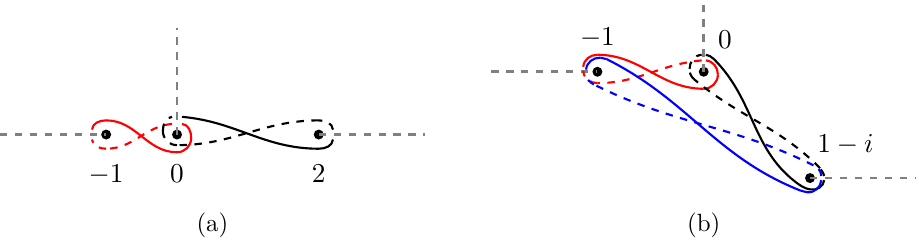
Figure 2. One-cycles on the WKB curves for the minimal chamber (a) and outside the minimal chamber (b). Moving from the minimal chamber to the next chamber in the moduli space, a new cycle is involved in the BPS spectrum charge basis. In this figure, the dashed black lines starting from the zeros (black dots) indicate the branch cuts. The black and red cycles are ˆ γ 1 , 1 and ˆ γ 1 , 2 respectively. The blue cycle is ˆ γ 1 , 1 + ˆ γ 1 , 2